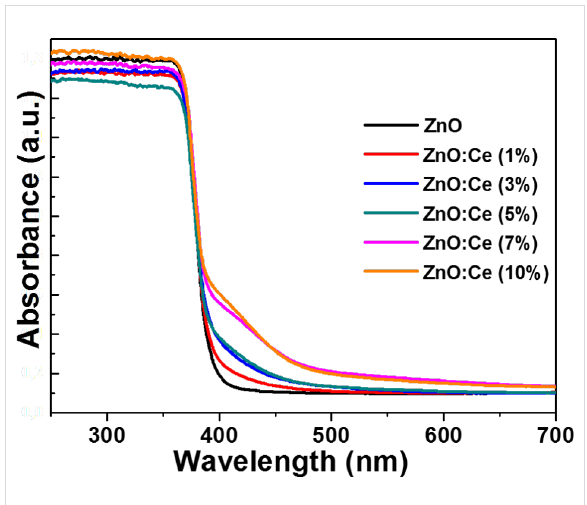
Figure 4: Room temperature UV–visible diffuse reflectance spectra of ZnO and Ce-doped ZnO